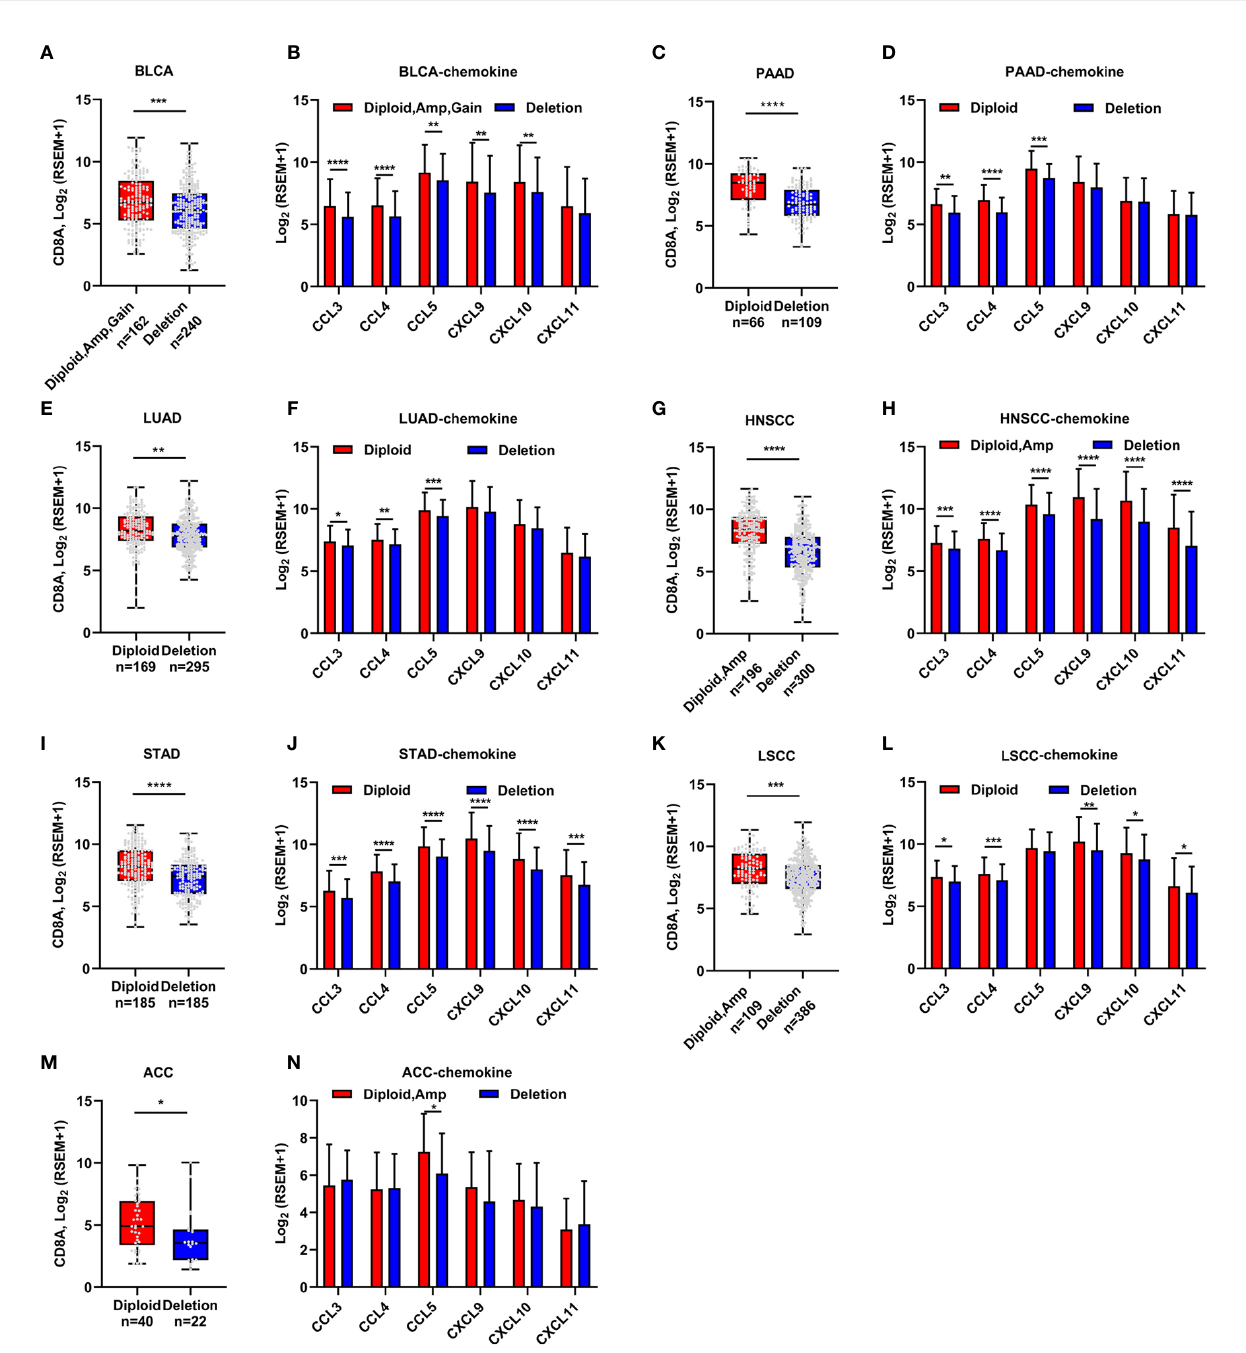
FIGURE 4 | The correlation of CDKN2A deletion and CD8A expression, T cell attracted chemokine expression in other cancers. (A – N) CD8A and the known chemokine expression in Urothelial Bladder Carcinoma (BLCA) patients with normal and/or ampli fi cated/gained and deleted CDKN2A (A, B) , in Pancreatic adenocarcinoma (PAAD, C, D ), in Lung Adenocarcinoma (TCGA-LUAD, E, F ), in Head and neck squamous cell carcinoma (HNSCC, G, H ), Stomach Adenocarcinoma (STAD, I, J ), in Lung squamous cell carcinoma (LUSC, K, L ), and in Adrenocortical carcinoma (ACC, M, N ). *p < 0.05, **p < 0.01, ***p < 0.001, ****P <